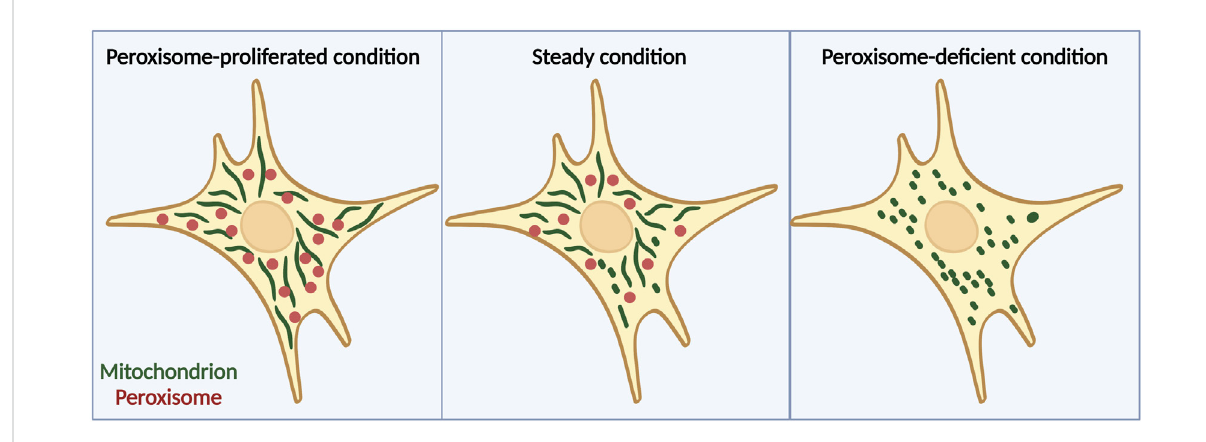
FIGURE 1 Peroxisomesareimportantforregulationofmitochondrialmorphology.Mitochondrial fi ssion-fusiondynamicsincellstreatedwith4-PBA(left), which induces peroxisome proliferation, cells under normal conditions (middle), and cells lacking peroxisomes due to Pex3 knockout (right). When peroxisome proliferation is induced pharmacologically, mitochondria acquire an elongated structure, whereas peroxisome de fi ciency leads to a more fragmented mitochondrial morphology. Note that in general, ZS only lacks peroxisomal matrix proteins but retains the membrane structures of peroxisomes. The fi gure is created with